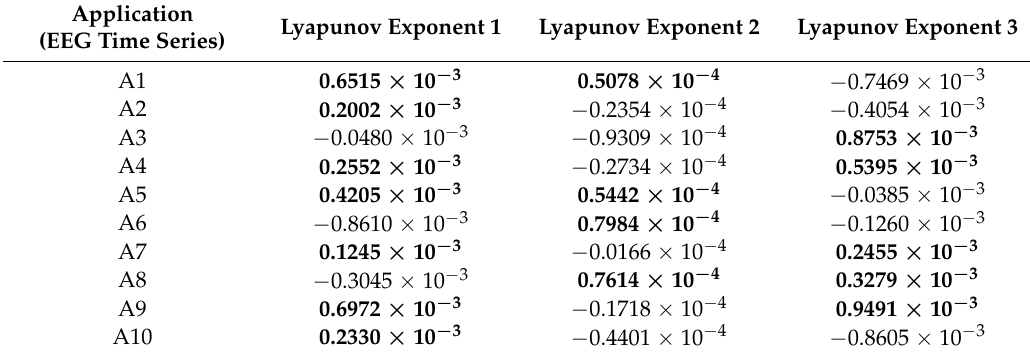
Table 1. Lyapunov exponents for each EEG time series application (Figure 5) in the study.